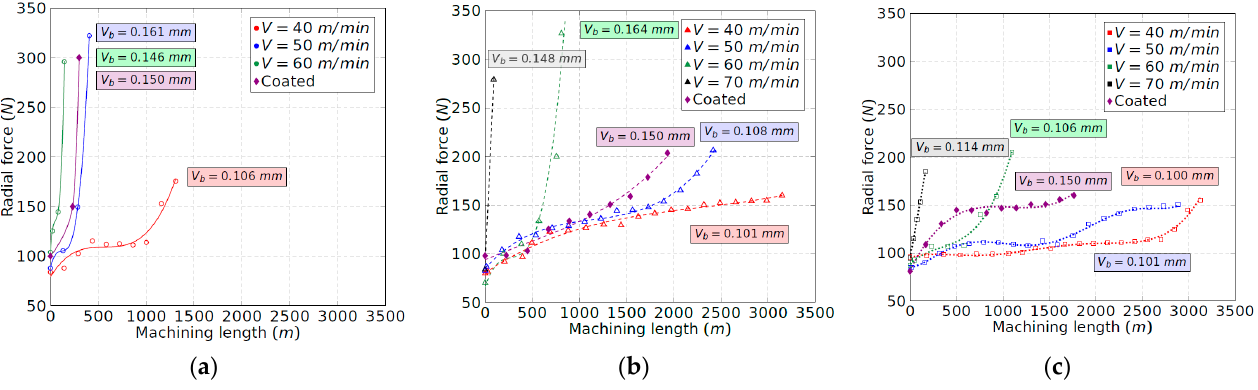
Figure 9. Radial force evolution vs. machining length: ( a ) tool configuration 1; ( b ) tool configuration 2; and ( c ) tool configuration 3.